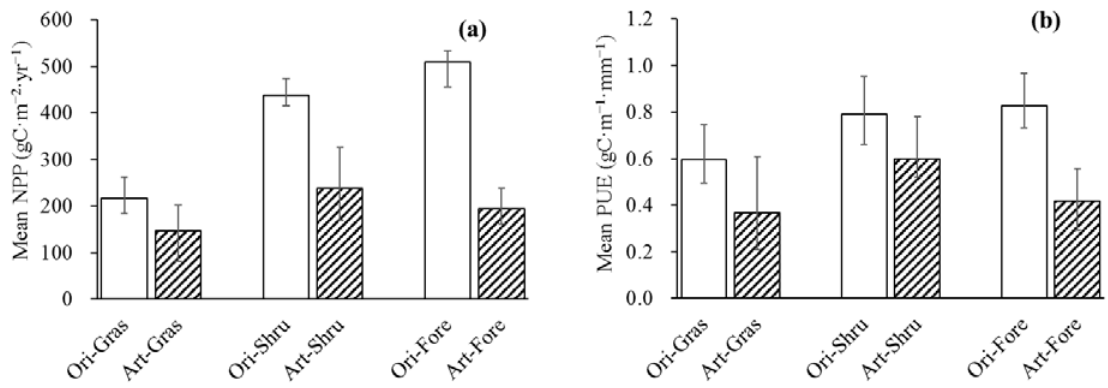
Figure 8. The mean NPP ( a ) and PUE ( b ) of original vegetation and artificial vegetation. Ori-Gras, Art-Gras, Ori-Shru, Art-Shru, Ori-Fore, and Art-For represented original grassland, artificial grassland, original shrub land, artificial shrub land, original forest and artificial forest, respectively. Error bar represented the standard deviation (SD).